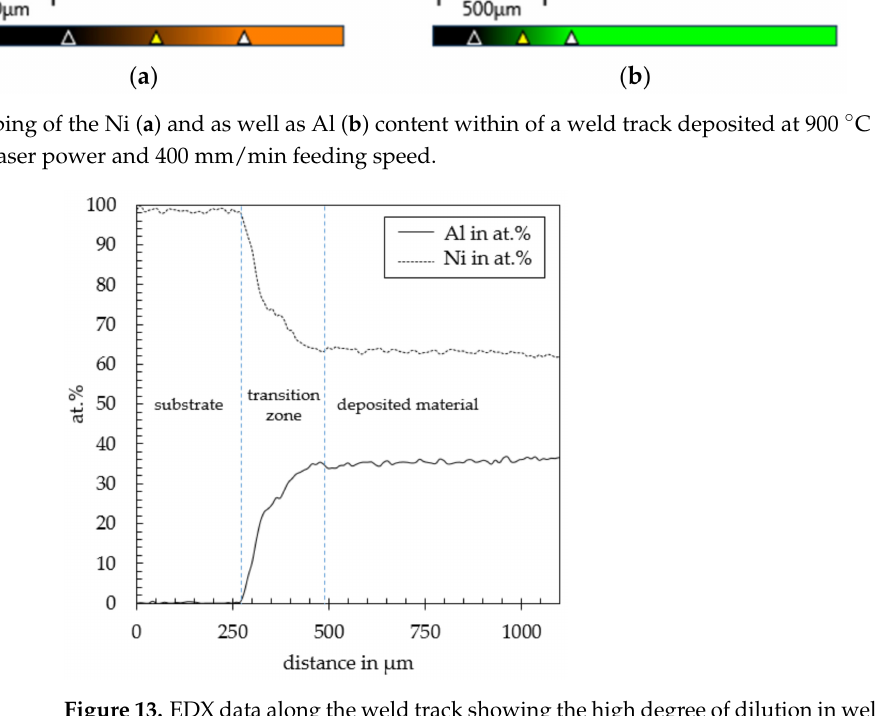
Figure 13. EDX data along the weld track showing the high degree of dilution in weld track deposited at 900 ◦ C pre-heating temperature, 800 W laser power and 400 mm/min feeding